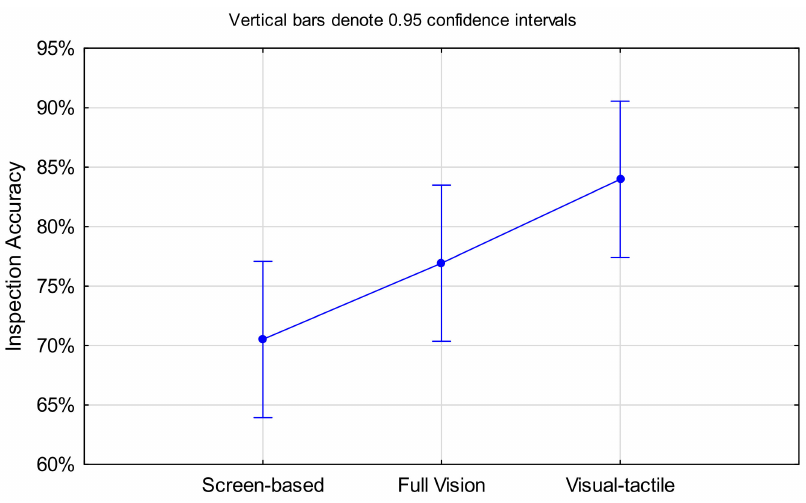
Figure 3. Mean plot of inspection accuracy by inspection Method.